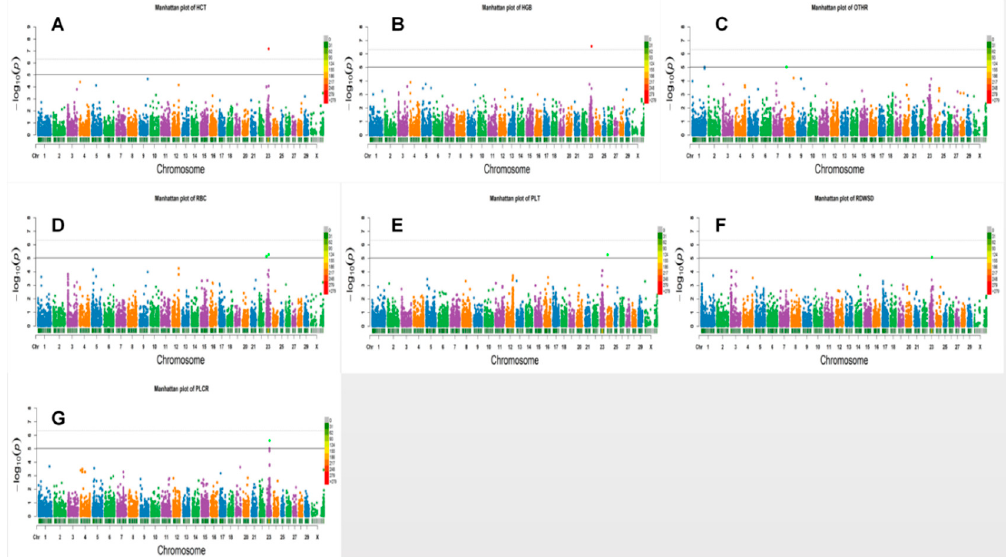
Figure 2. Manhattan plots for the haplotype analysis of hematological traits surpass the genome-wide significant threshold. Log 10 (1 / p -value) values are shown for all SNPs that passed quality control. The numbers indicate the chromosomes in the genome. The solid line and dotted line denote the Bonferroni-corrected genome-wide and suggestive significant threshold, respectively. SNPs surpassing the genome-wide threshold are highlighted in red and SNPs reaching the suggestive threshold in green. The bars below each chromosome are the density of the markers. E.g., Manhattan of HCT means Manhattan map obtained by haplotype analysis of HCT traits. HCT: hematocrit; RBC: red blood cell count; HGB: hemoglobin; OTHR: medium white blood cell count; PLT: platelet count; RDW-SD: red blood cell volume distribution width-SD; PLCR: platelet count.( A – G ) Manhattan plot representing HCT, HGB, OTHR, RBC, PLT, RDWSD and PLCR traits, respectively